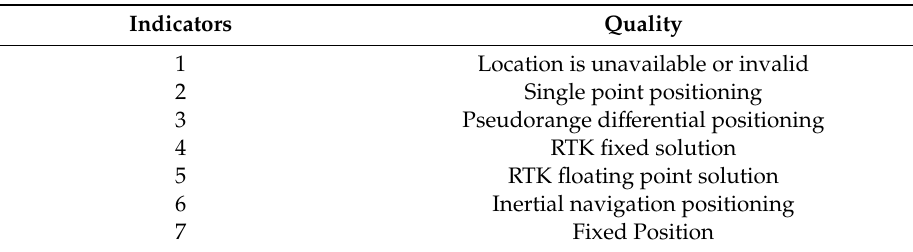
Table 1. Quality indicators.